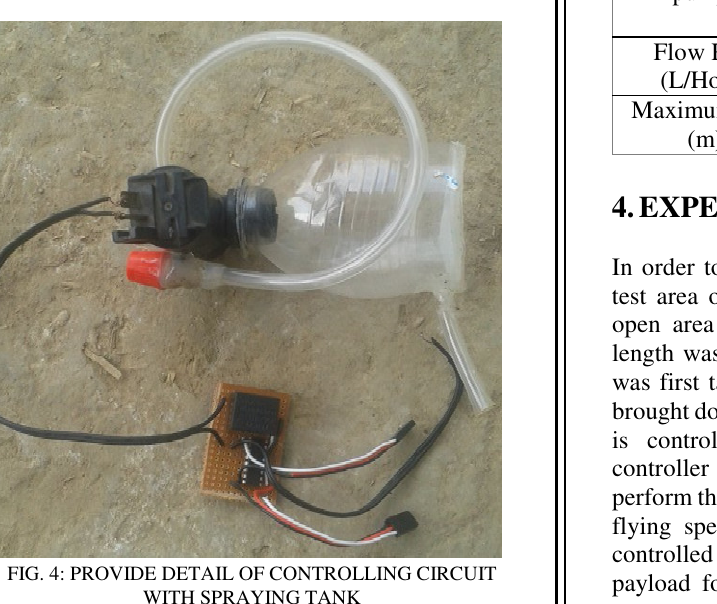
FIG. 3: CONTROL CIRCUIT FOR THE SPRAYING